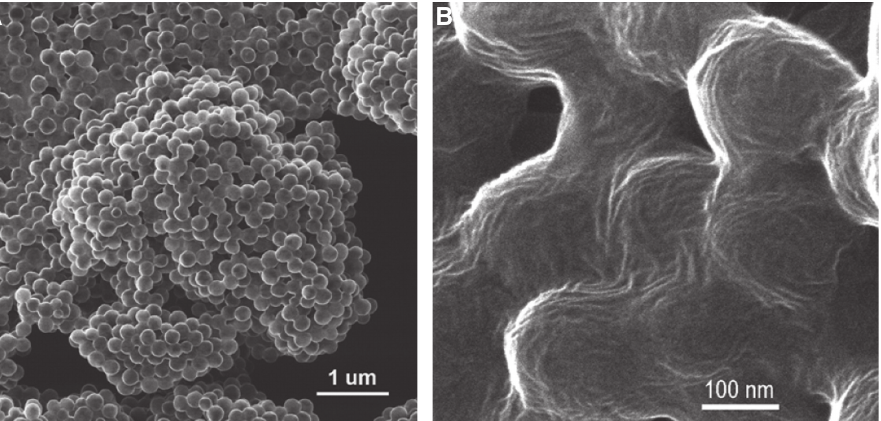
Figure 4 HIM imaging of PVDF-PANI core-shell nanoparticles. (A) nanoparticle aggregates formed after casting from chloroform dispersion; (B) porous monolithic film formed after short term annealing of the solution cast film at 180 ° C (above the melting transition temperature of the PVDF